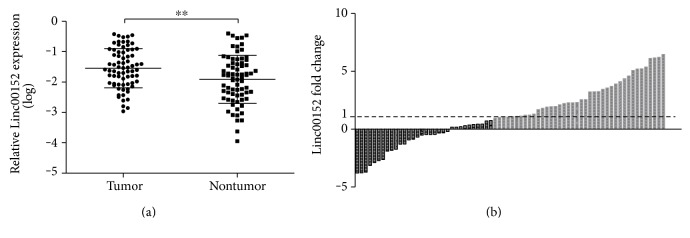
(a) The expression levels of Linc00152 in NSCLC tissues and adjacent normal tissues, ∗∗P < 0.001; (b) Waterfall plot showed Linc00152 was increased by at least twofold in 55.6% (39/72) of NSCLC tissues. The gray areas represent that linc00152 was upregulated by at least twofold. Fold change was represented by 2−ΔΔCt, and −ΔΔCt = −[(CtLinc00152 − CtGAPDH) of NSCLC − (CtLinc00152 − CtGAPDH) of normal].